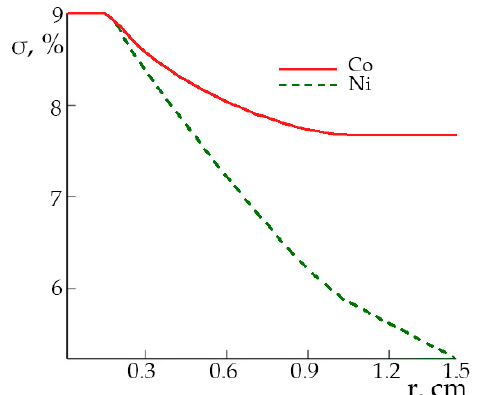
Figure 4. The laminar flow during a central solution supply: radial profiles of supersaturation over the crystal surface for Co and Ni components. The supersaturation in the inward jet area σ = 9.0% and the inflow velocity V jet = 90 cm/s.